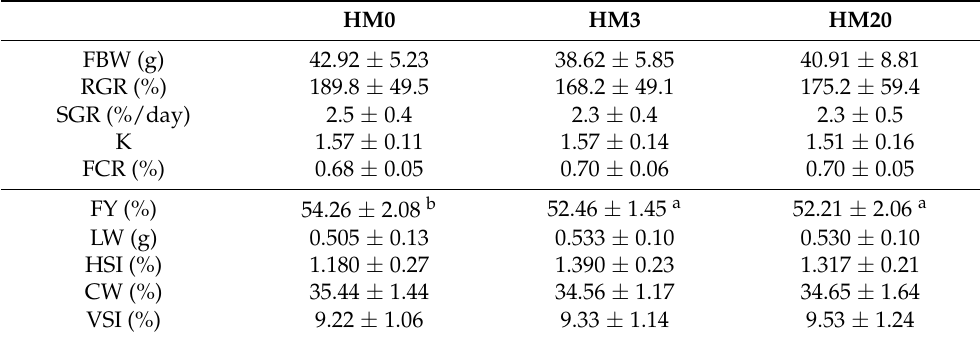
Table 4. Growth performance parameters, condition factor (K), and marketable indexes of rainbow trout fed experimental